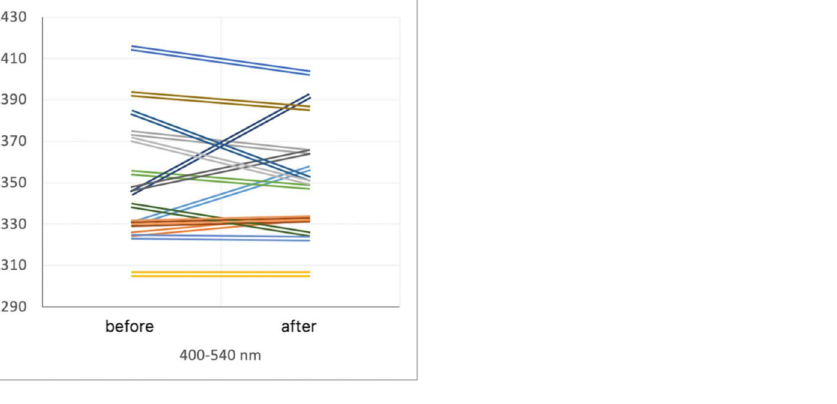
Figure 3. Average results of 3 reflectance measurements at a wavelength of 400–540 nm in every woman undergoing microdermabrasion, before and after the procedure.